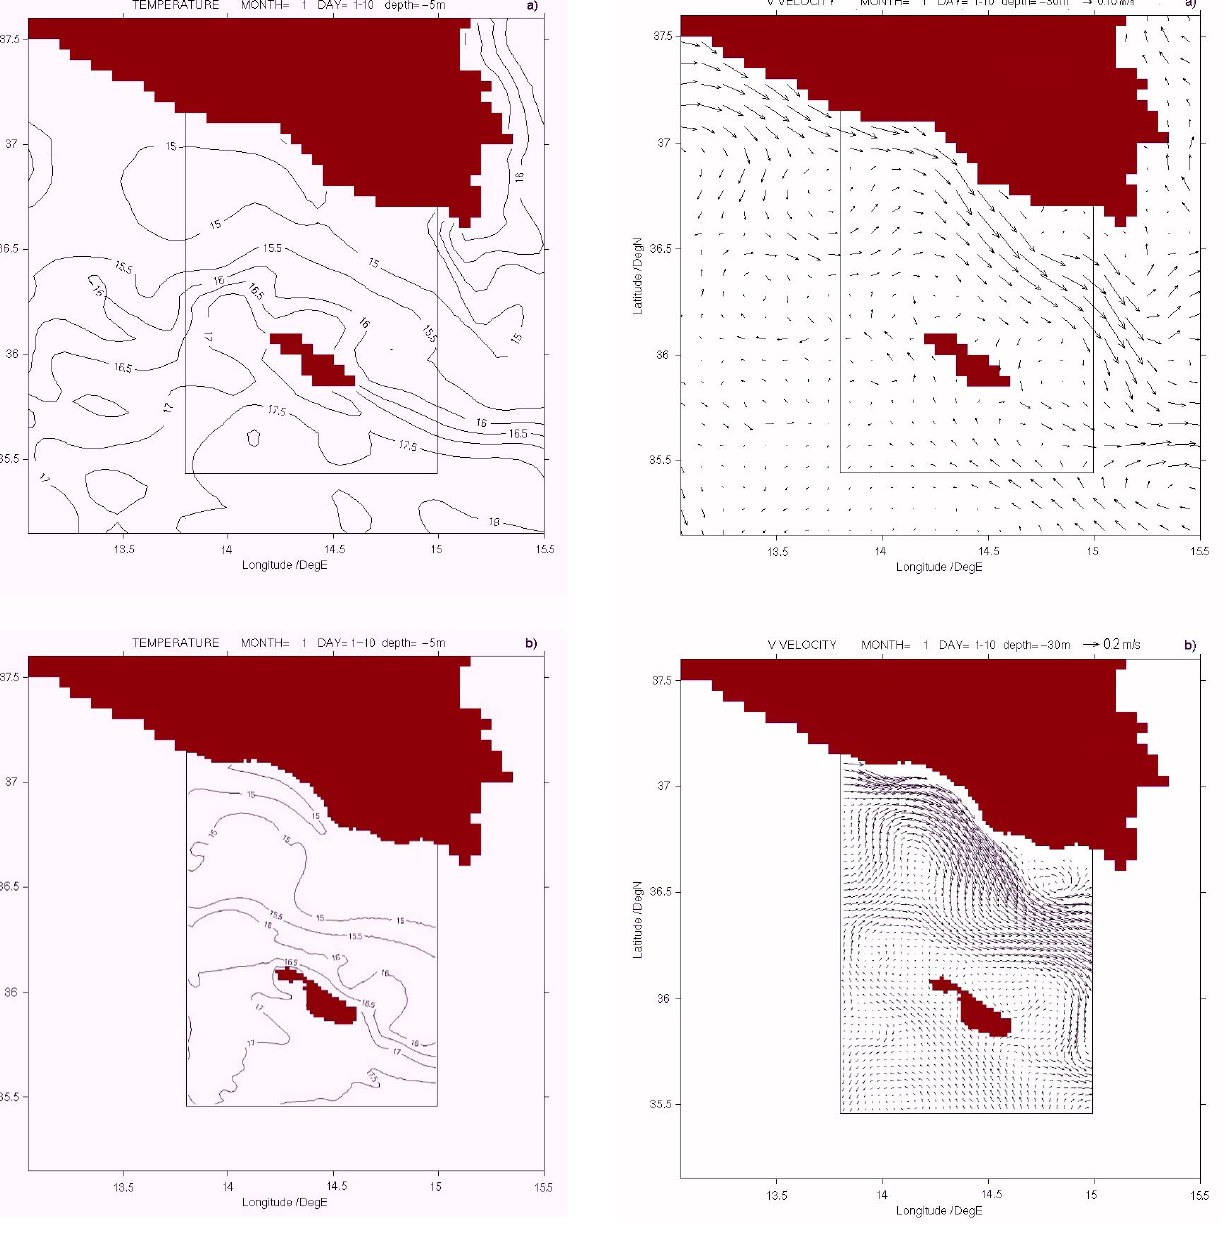
Fig. 10. Comparison of the 10-day averaged 2-D flow field at 30m depth in January simulated by (a) the coarse resolution model and (b) the benchmark high resolution shelf